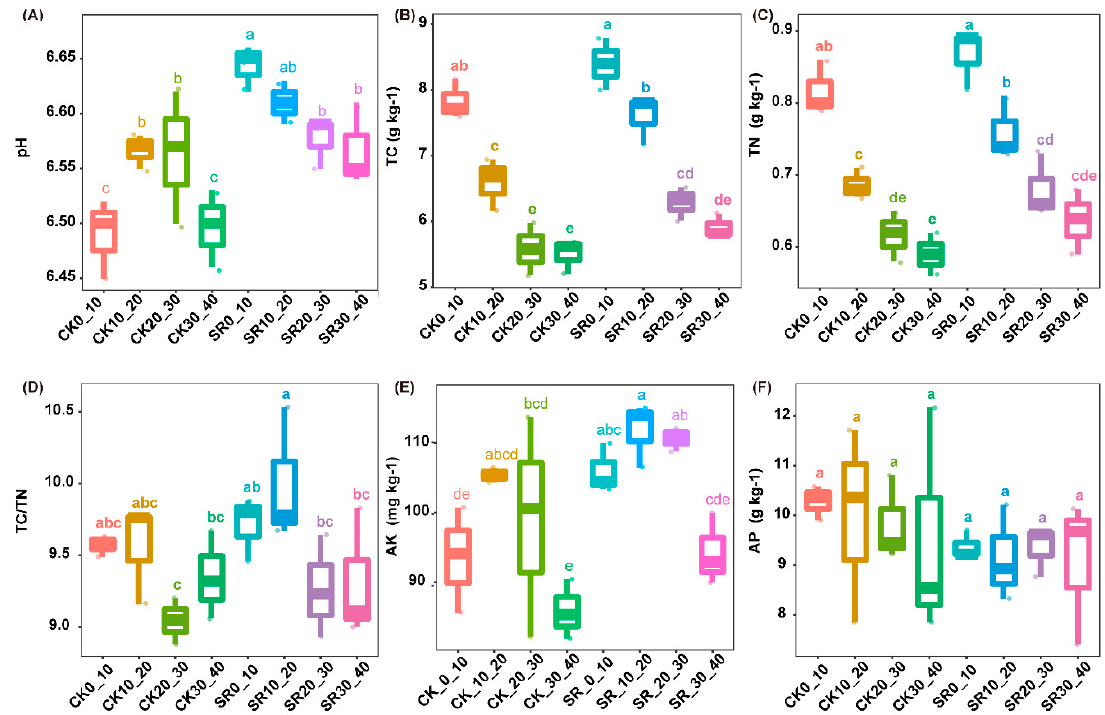
Figure 1. Soil physiochemical properties at 0–40-cm depths in the sugarcane straw retention (SR) treatment compared to the control (CK). Error bars in the boxplots with different lowercase letters show significant differences between treatments (Tukey test, p < 0.05). ( A ) pH, potential hydrogen; ( B ) TC, total soil carbon; ( C ) TN, total nitrogen; ( D ) C/N, carbon/nitrogen ratio; ( E ) AK, available potassium; ( F ) AP, available phosphorus.